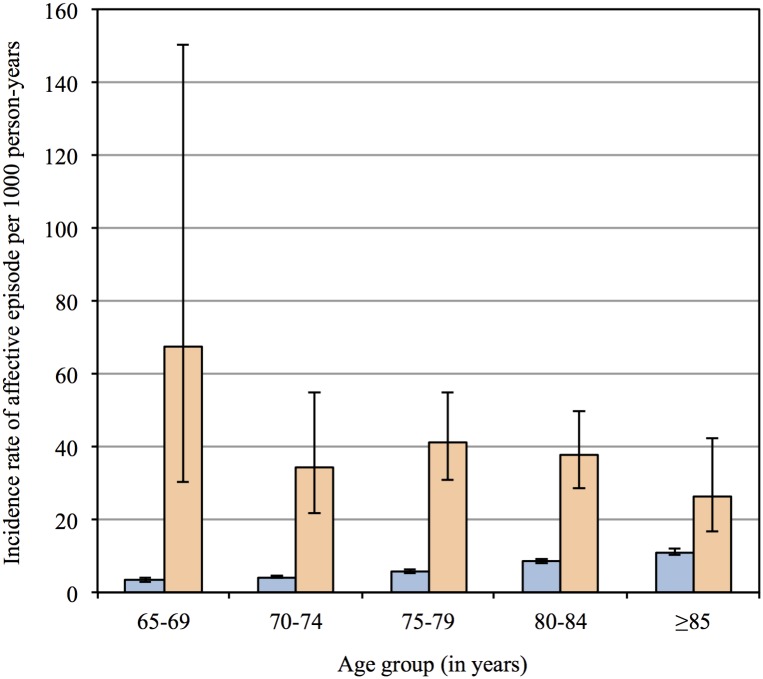
The bars depict the incidence rate of affective episodes per 1000 person-years for each age group, and the whiskers represent the 95% confidence interval of the rates.The left and right bars for each age group show the results for men without and with Parkinson’s disease respectively.